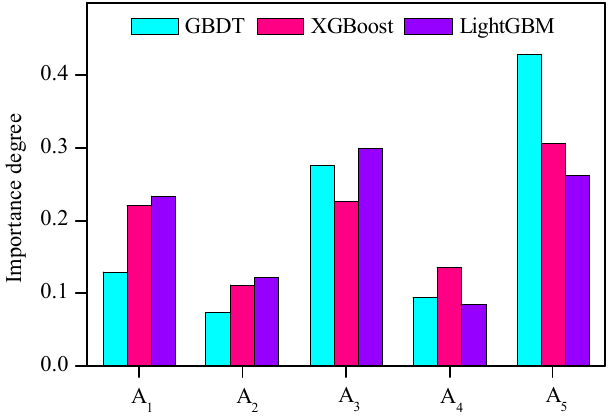
Figure 11. Importance degree of each indicator.